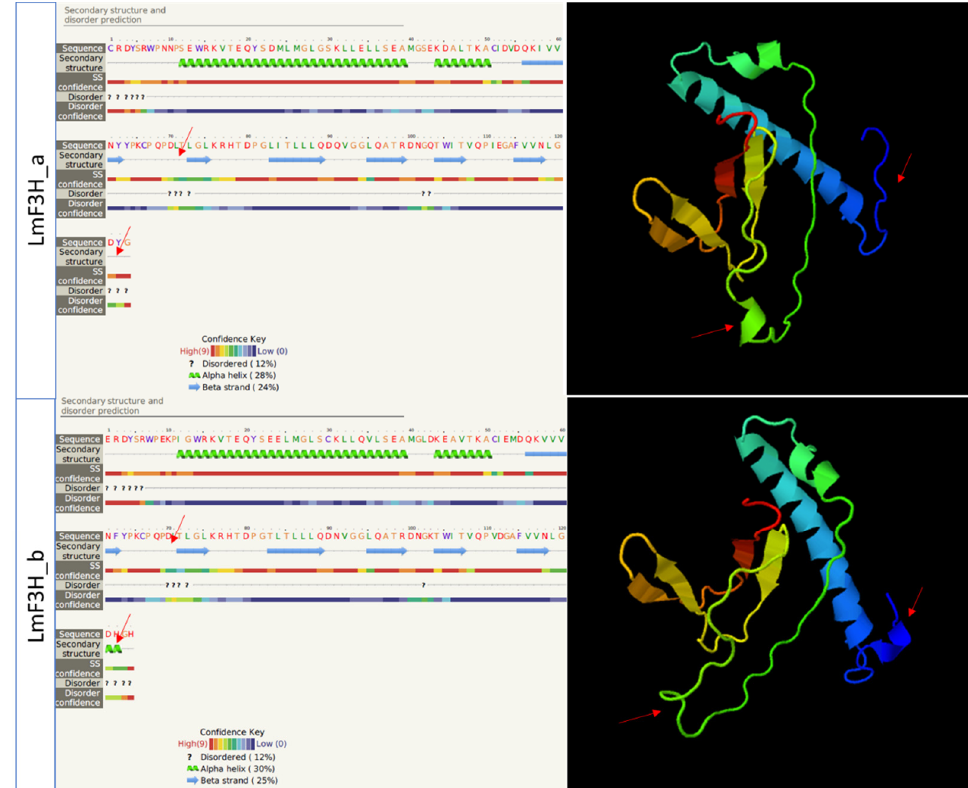
Figure 5. Predicted secondary (left) and tertiary (right) structures of LmF3H_a (top) and LmF3H_b (bottom) partial polypeptides in Lupinus mutabilis . Arrows indicate the region responsible Figure 3. H_a protein the beta strand starts in aa. 73 and ends in 74 position while, in LmF3H_b protein, this region is longer, starting at aa. 72 and ending in position 75. The mutation changing amino acid Y (LmF3H_a) to H (LmF3H_b) at position 122 resulted in the production of the short alpha helix. In the three-dimensional representations, images are coloured by rainbow N->C terminus.